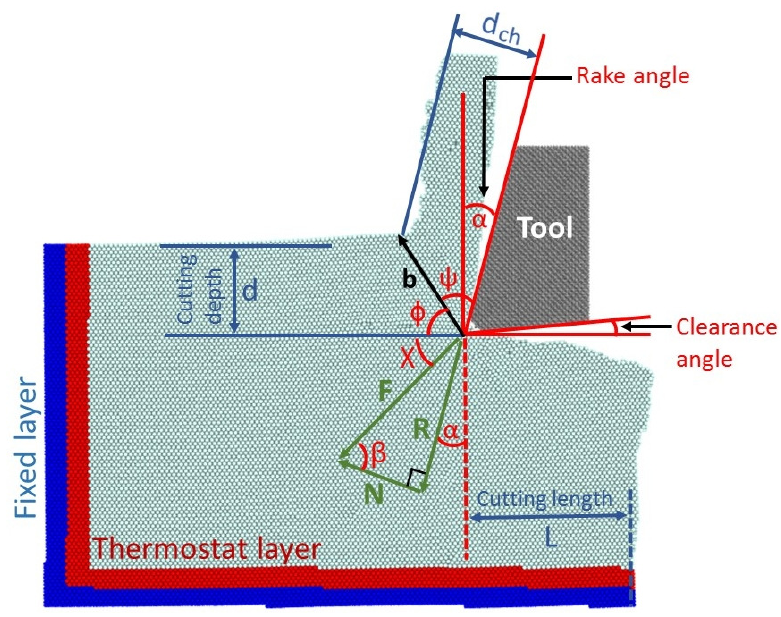
Figure 1. Schematics of the simulation setup showing important quantities characterizing the geometry of the cutting and of the chip. Quantities are defined in the